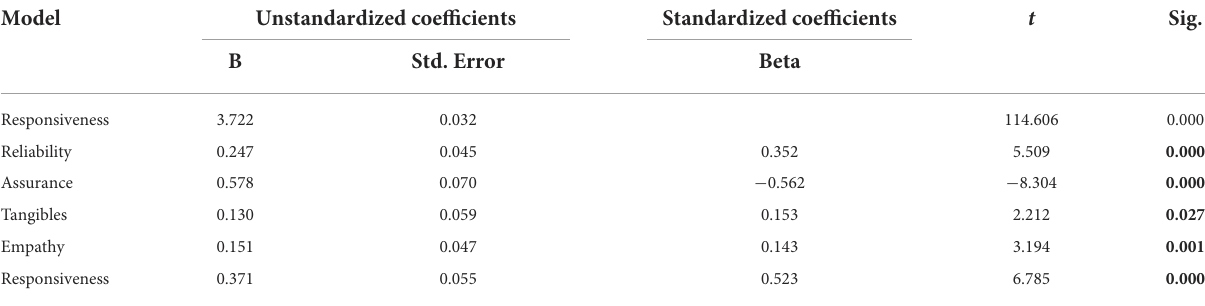
TABLE 9 Regression coefficients on the GAP for public hospitals.